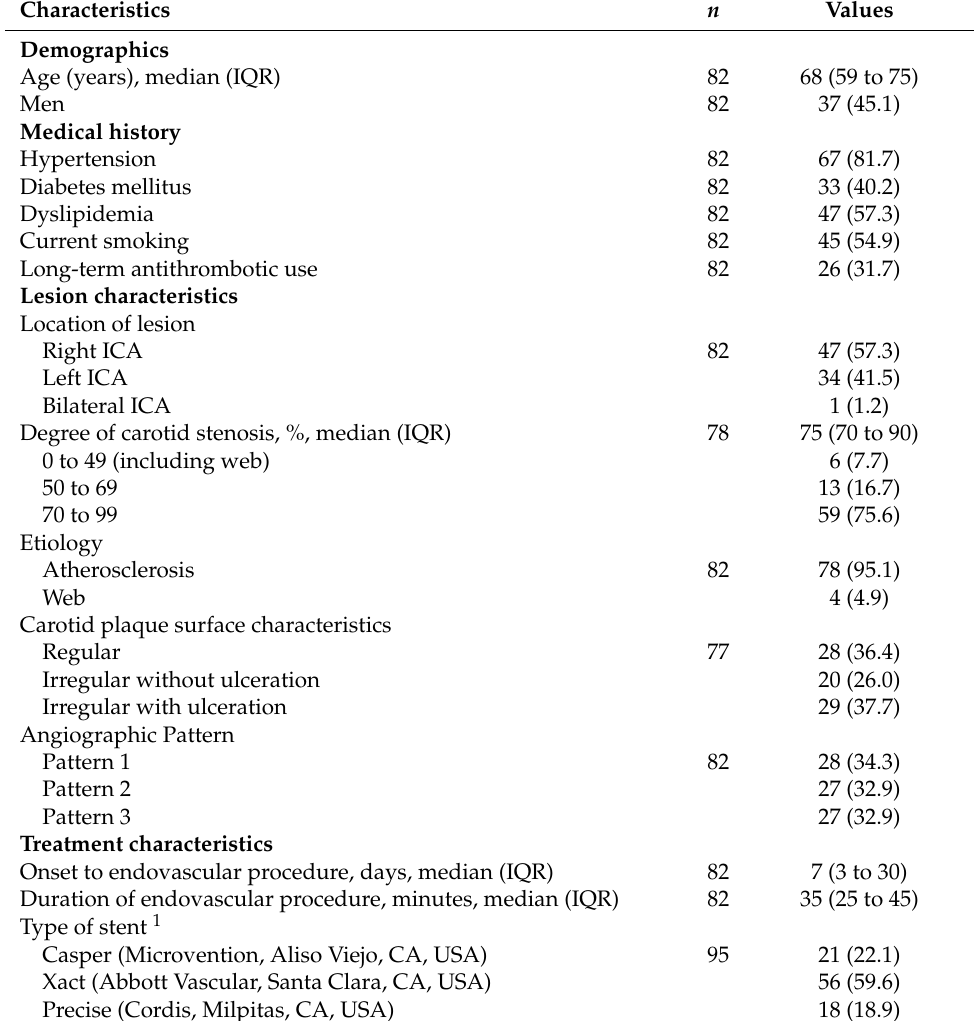
Table 1. Patient and treatment characteristics of the 82 included patients with symptomatic carotid stenosis >50% or symptomatic web treated by CAS using